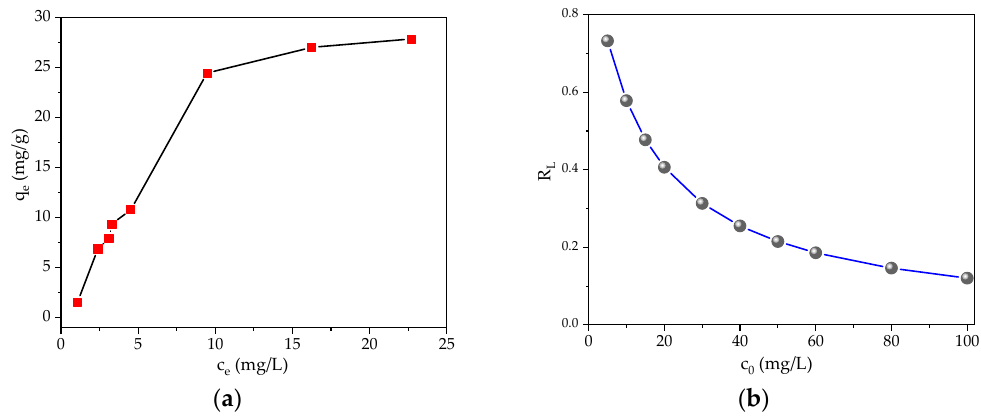
Figure 7. Adsorption isotherms of MB ( a ) and R L for the adsorption of MB ( b ) onto gelatin/ β -CD composite fiber adsorbents.